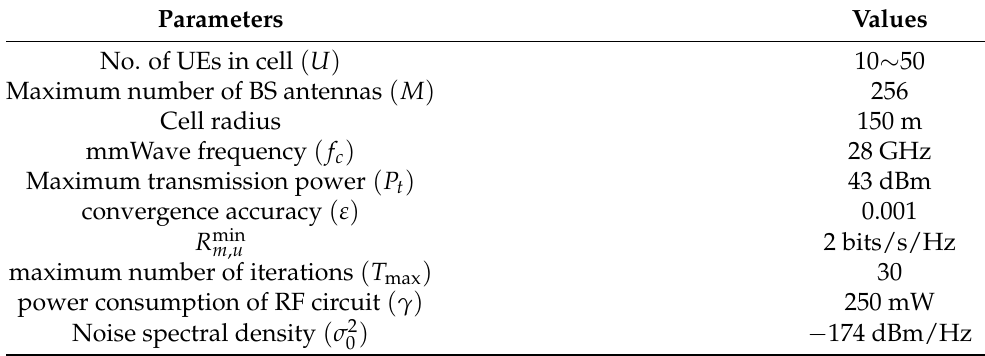
Table 1. Simulation parameters setting. UE: User; BS: Base station; RF: Radio